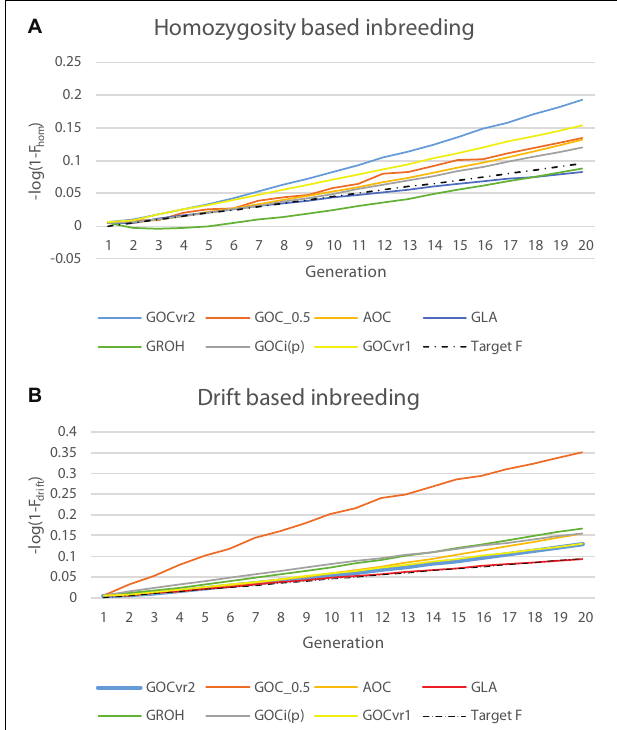
FIGURE 4 | Changes in inbreeding coefficients F drift and F hom for the neutral loci of Panel N over time plotted on a logarithmic scale where a constant rate of inbreeding results in a linear increase of over time: (A) natural logarithm of (1–F hom ); and (B) natural logarithm of (1–F drift ).